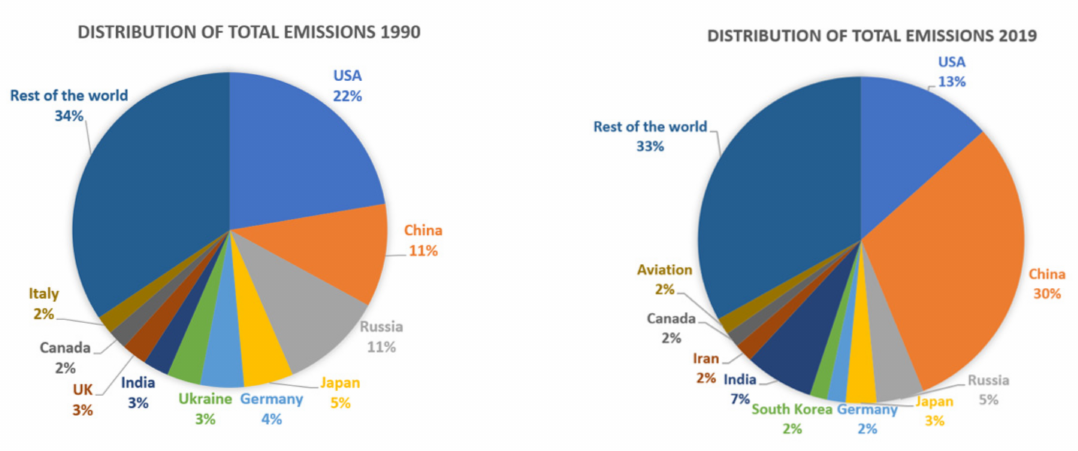
Figure 1. Distribution of global emissions 1990 vs. 2019. Own